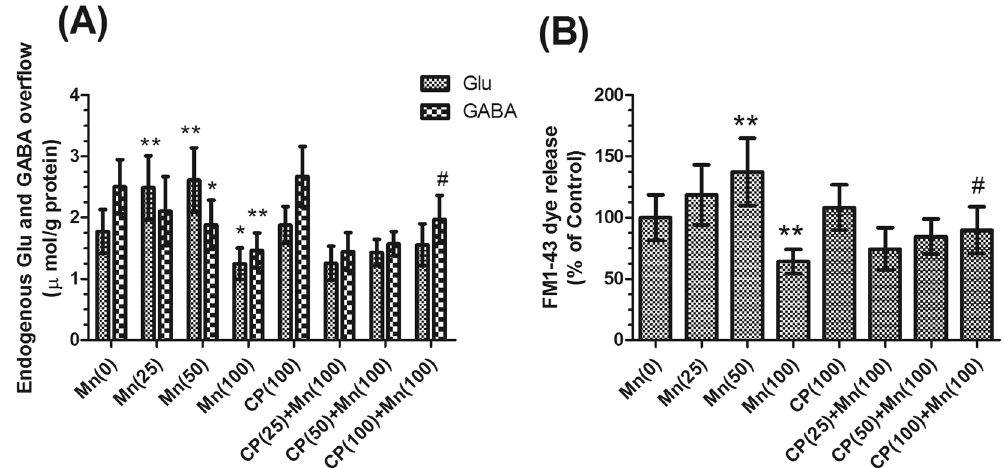
Figure 4. Calpeptin abated the Mn-induced decrease of neurotransmitters release. ( A ) Effects of MnCl 2 and calpeptin pre-treatment on Glu and GABA release in basal nuclei by using HPLC. ( B ) Effects of MnCl 2 and calpeptin pre-treatment on neurotransmitter release by using release of the fluorescent dye FM1-43. Data are expressed as a percentage of controls, the values are expressed as means ± S.D., n = 6. * P < 0.05 and ** P < 0.01 significantly different form control group; # P < 0.05, significantly different form 100 μ mol/kg MnCl 2 -treated